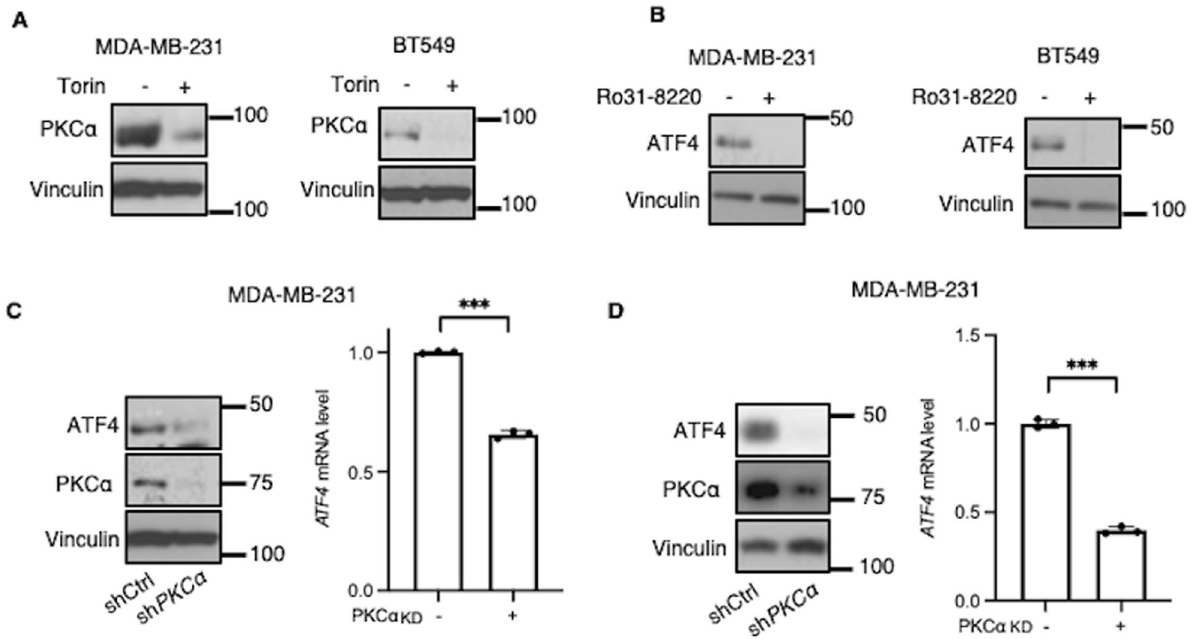
Fig. 3 mTORC2 signals to PKC to promote ATF4 transcription. A Western blot analysis of WCL from MDA-MB-231 and BT549 cells treated with CB-839 (1 μ M) ± Torin1 (500 nM) for 24 h. Blots are representative of three (MDA-MB-231) or two (BT549) independent experiments. B Western blot analysis of WCL from MDA-MB-231 and BT549 cells treated with CB-839 (1 μ M) ± Ro31-8220 (5 μ M) for 24 h. Blots are representative of two independent experiments. C Western blot analysis of WCL and RT-qPCR quanti fi cation of ATF4 mRNA in control and PKC α KD MDA-MB-231 cells treated with CB-839 (1 μ M) for 24 h. Blots are representative of three independent experiments. qPCR data shown are representative of two independent experiments and expressed as means ± SD for triplicate measurements. D Western blot analysis of WCL and RT-qPCR quanti fi cation of ATF4 mRNA in control and PKC α KD MDA-MB-231 cells deprived of glutamine for 24 h. Blots are representative of two independent experiments. qPCR data shown are representative of two independent experiments and expressed as means ± SD for triplicate